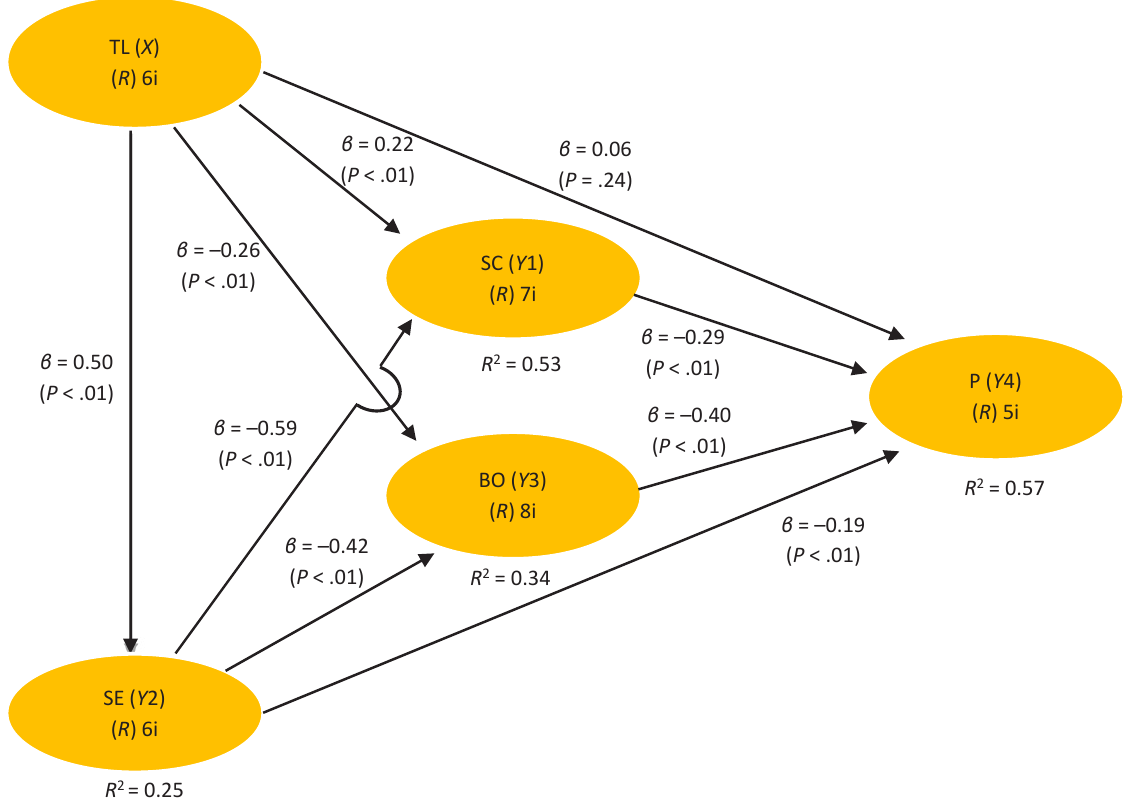
Figure 1. Research model analysis